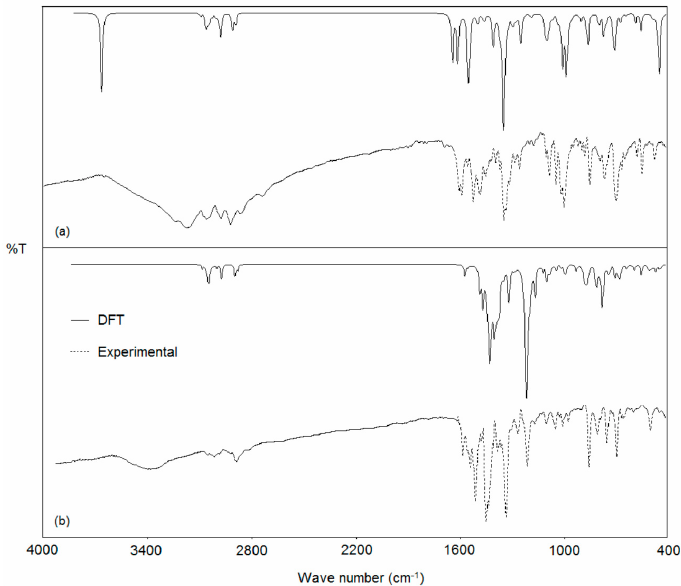
Figure 8. Experimental and calculated IR spectra of the ( a ) nppeieoH and ( b ) [Pd(nppeieo)(ninap)].